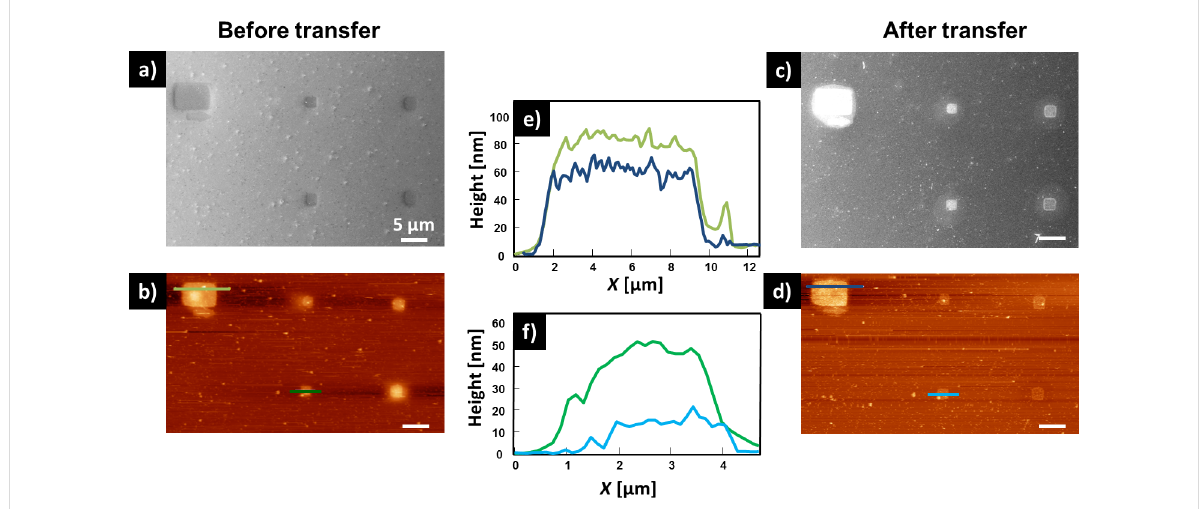
Figure 5: Transfer of a CNM with Fe structures on top onto a SiO 2 sample. (a) SEM image of the Fe structures fabricated with EBID on a TPT SAM on Ag(111)/mica. (b) AFM image of the structures depicted in (a). (c) SEM image of the Fe structures depicted in (a) after the transfer to bulk SiO 2 . (d) AFM image of the Fe structures after the transfer to bulk SiO 2 . (e) Height profile of the larger marker structure before and after the transfer. (f) Height profile of a smaller square structure before and after the